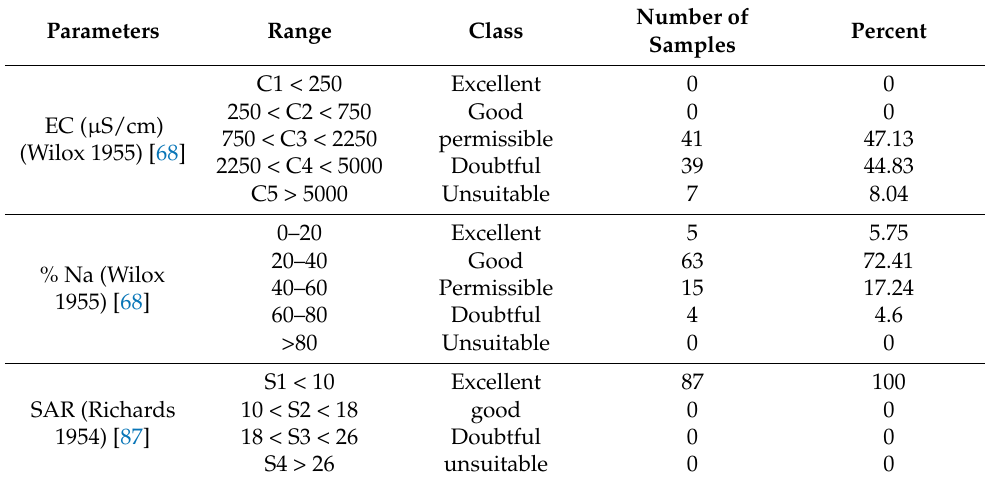
Table 4. Sustenance of groundwater for irrigation based on EC, %Na and